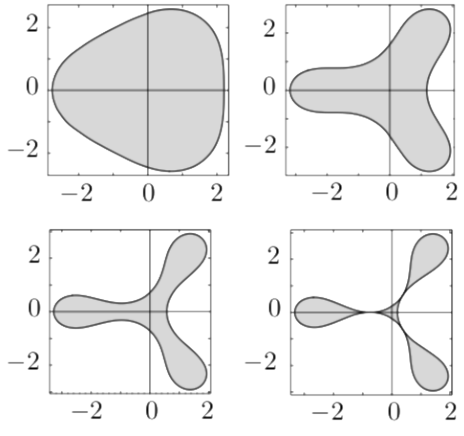
Figure 5. The four panels (obtained in Ref. [22] via the method of thermo-vorticial spots) illustrate that uniformly rotating macro-structures may take various shapes depending on guiding parameters: the shape may range from a weakly deformed circle to a sharply pronounced three-petal “flower”. Other guiding parameters define how many petals appear: two, three, etc. The theory and models are explained in detail in Ref. [22]. The units for axes are the same as in Figure